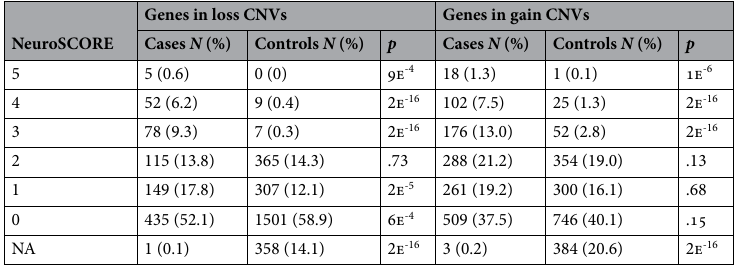
Table 3. Distribution of the highest scored gene within case and control CNVs. NA are genes that could not be scored (e.g., pseudogenes); total case CNVs N LOSSES = 835, N GAINS = 1357, total control CNVs N LOSSES = 2547, N GAINS = 1862; For statistical testing, Fisher’s Exact test was used for analyses when genes in CNVs were ≤ 5, while Chi squared tests were used for analyses when genes in CNVs were > 5; significance set at p ≤ 4e -3 after Bonferroni correction for 14 tests.